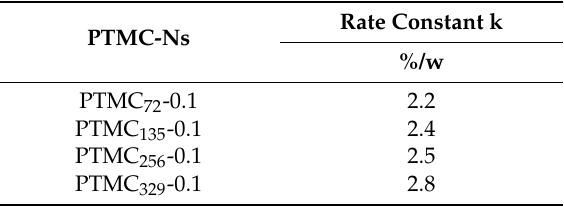
Table 3. The enzymatic degradation rate of BTB cross-linked PTMC-Ns with different initial molecular weight determined from the increase of mass loss.